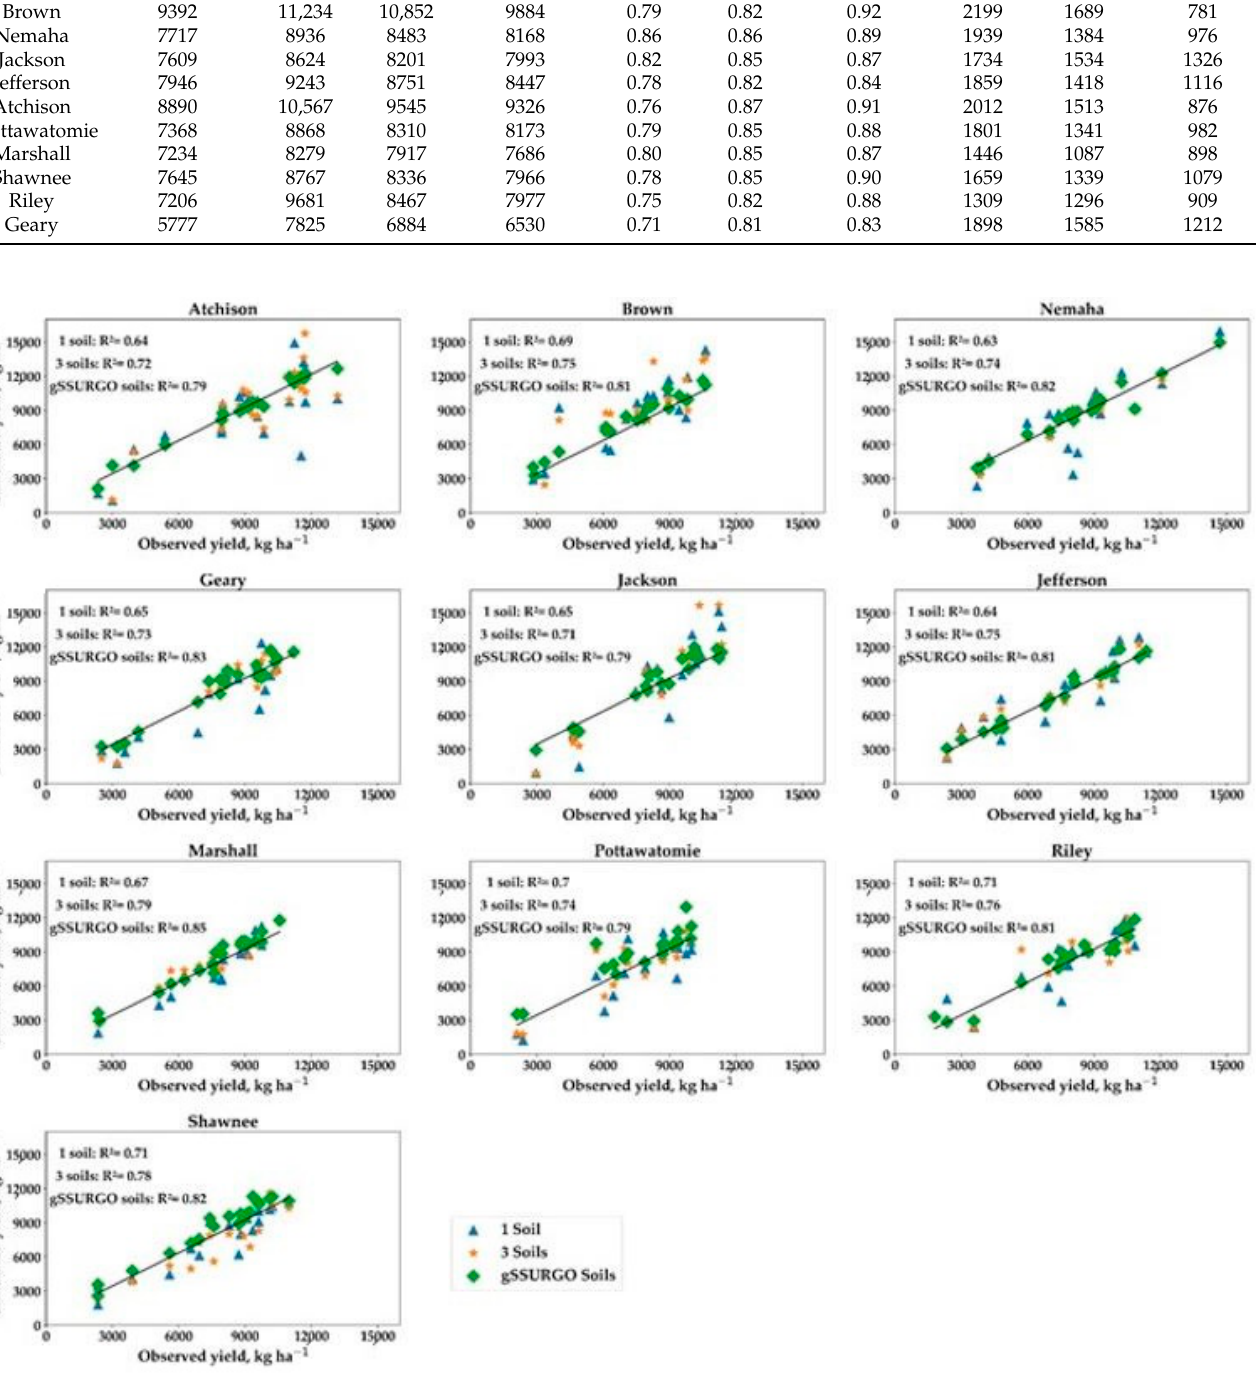
Figure 5. Comparison between DSSAT-CERES simulated and observed yields for the baseline study period in the top ten maize-producing counties of eastern Kansas while using the one most dominant soil, the three most dominant soils, and spatially distributed gSSURGO soils for each county.